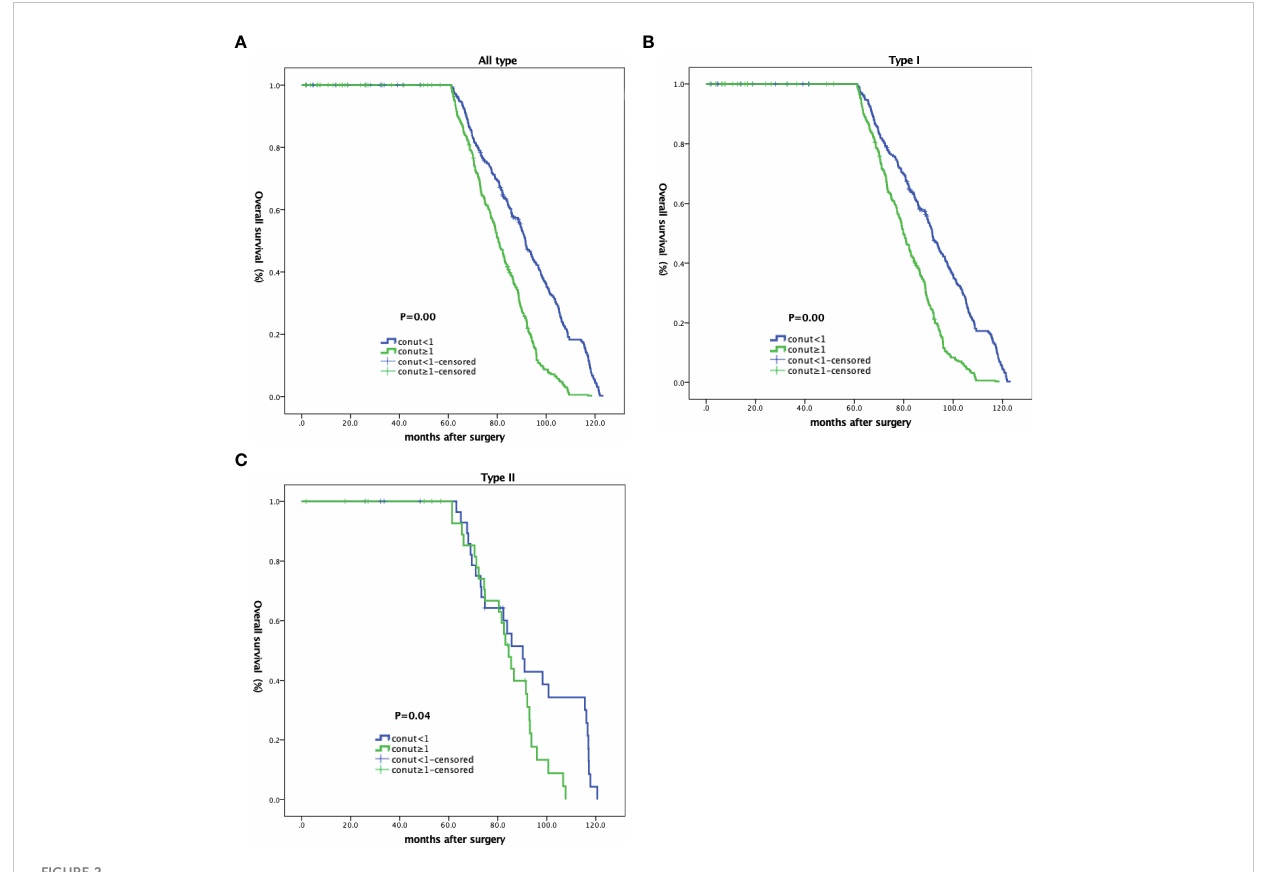
TABLE 4 CONUT score associations with overall survival (OS) rates. N=767